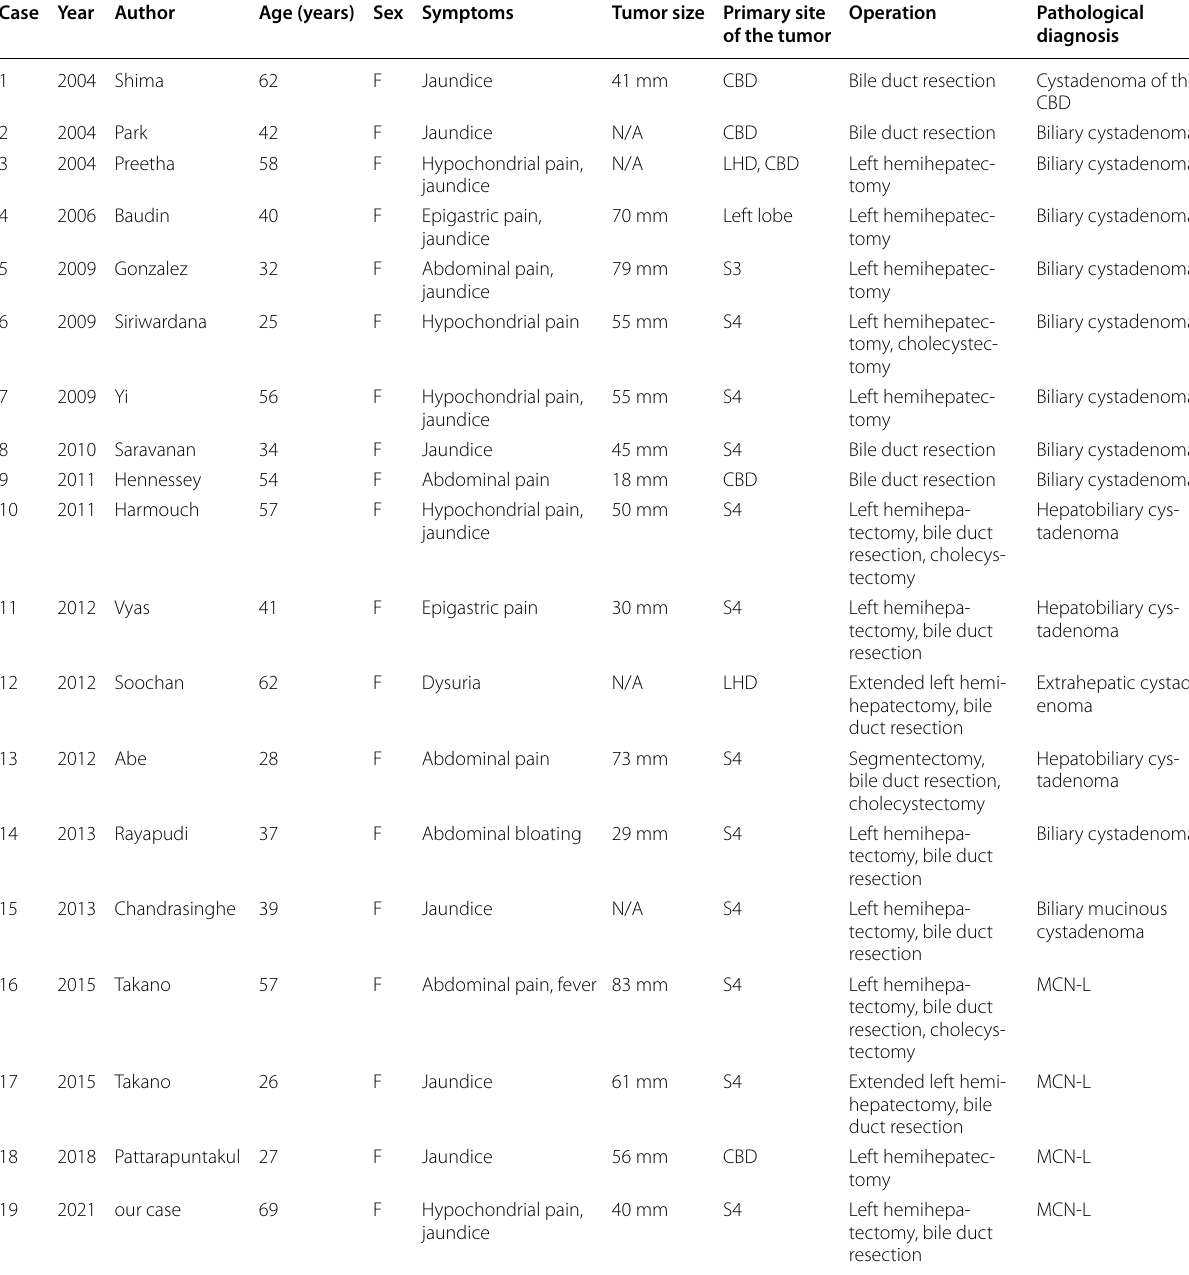
F female, N/A not applicable, CBD common bile duct, LHD left hepatic duct, S segment, MCN-L mucinous cystic neoplasm of the